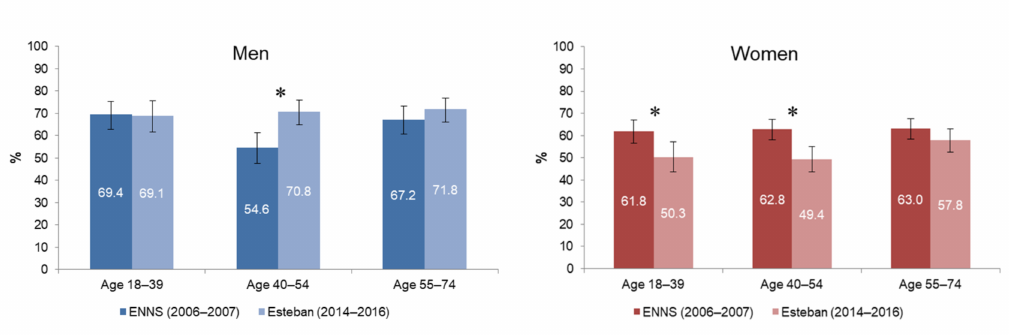
Figure 2. Prevalence of physical activity in men and women aged 18–74 years, between ENNS (2006–2007) and Esteban (2014–2016). * significant change (p < 0.01).